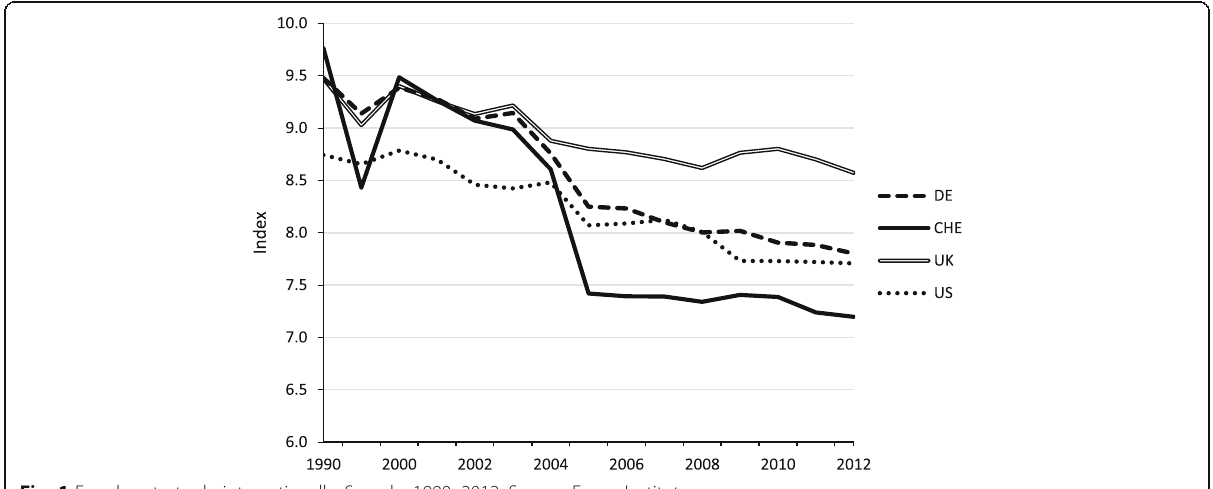
Fig. 1 Freedom to trade internationally. Sample: 1990 – 2012, Source: Fraser Institute